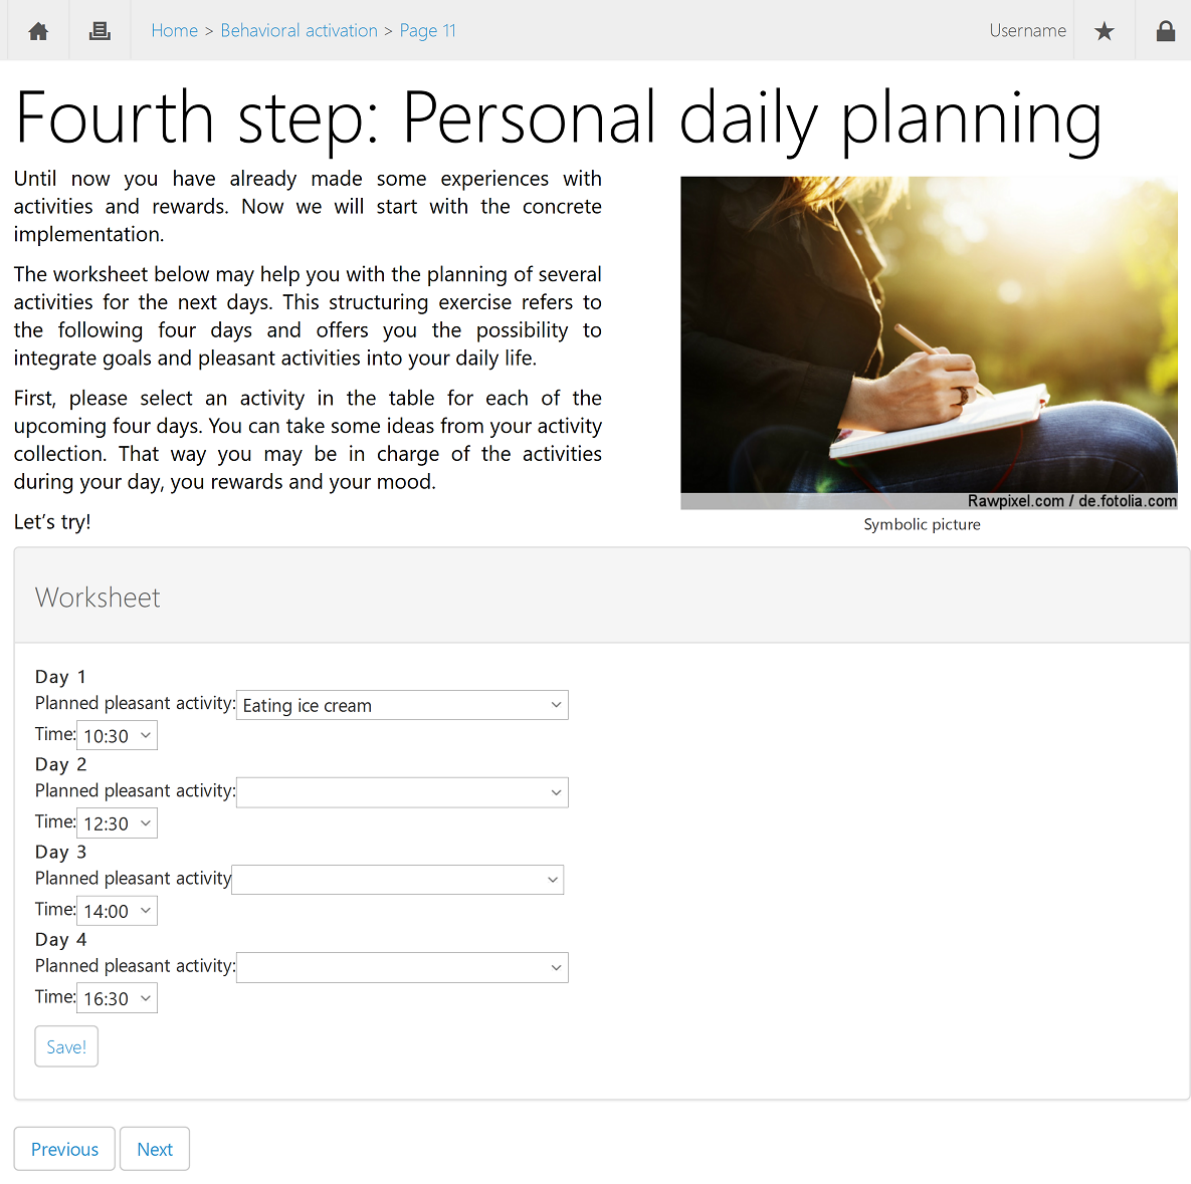
Figure 2. Screenshot of the experimental, internet-based behavioral activation intervention